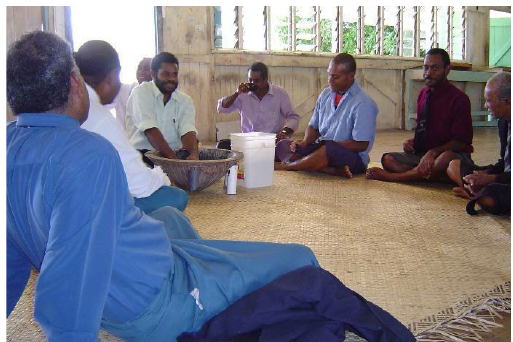
Figure 5: Teachers drinking yaqona in the school hall after hours (photographer: Apo Aporosa,